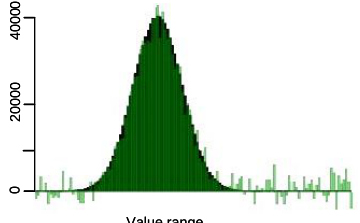
Figure 2. Normal distribution using